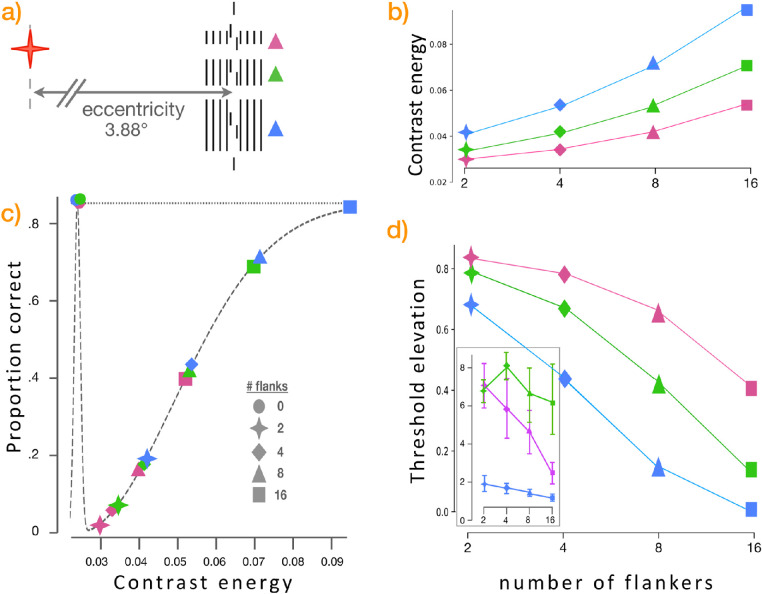
(a) Varied numbers of flanking lines around a fixed target vernier whose two components were either left–top/right–bottom (shown) or right–top/left–bottom; that distinction is what human subjects were asked to report. Experimental configurations replicated herein were two, four, eight, or 16 lines surrounding the target vernier (all at a fixed eccentricity of 3.88 visual degrees from the fixation point). (b) As before, the calculated contrast energy metric (Equation 4) is shown for each flank configuration, as in the legend shown in inset table in part (c). Contrast energy is higher for larger flankers (blue > green > red) and increases with added flankers (two, four, eight, or 16). (c, d) This relationship continues across the range of mapping calculations (Equation 5), generating predicted recognition success rates given numbers of flankers of various sizes. Low threshold elevation predicts little or no crowding; larger threshold elevations indicate crowding (i.e., degradation of recognition performance). The inset in (d) shows corresponding reported findings from Manassi et al. (2012), some of which may disagree with the predictions from the contrast metric; these are further discussed in the text.